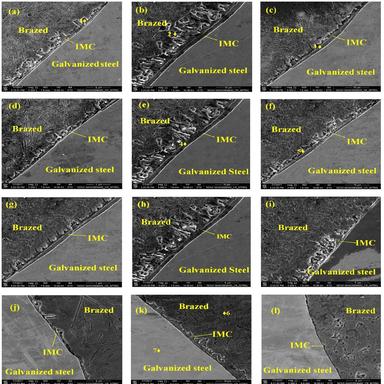
Microstructures of laser brazed joints interfaces (steel side) at different locations with varying laser power: (a, b, c) 4.5 kW, (d, e, f) 3.5 kW, (g, h, i) 3 kW, (j, k, l) 2.5 kW.